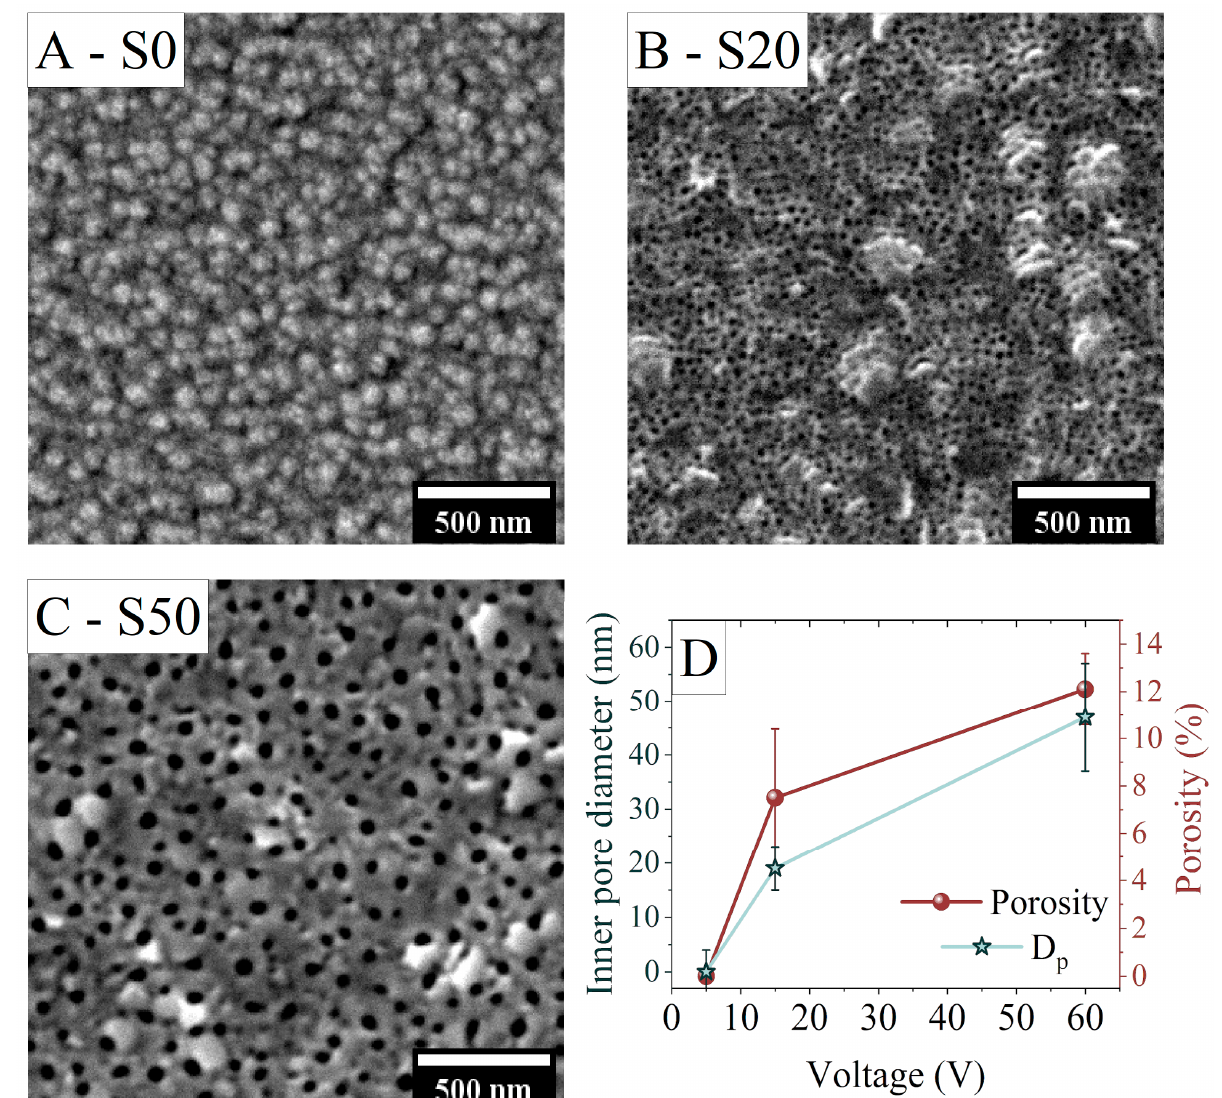
Figure 1. The morphology of anodized titanium oxide obtained at ( A ) 5 V, ( B ) 15 V, and ( C ) 60 V. The voltage impact on the inner pore diameter and the porosity is shown in ( D ).